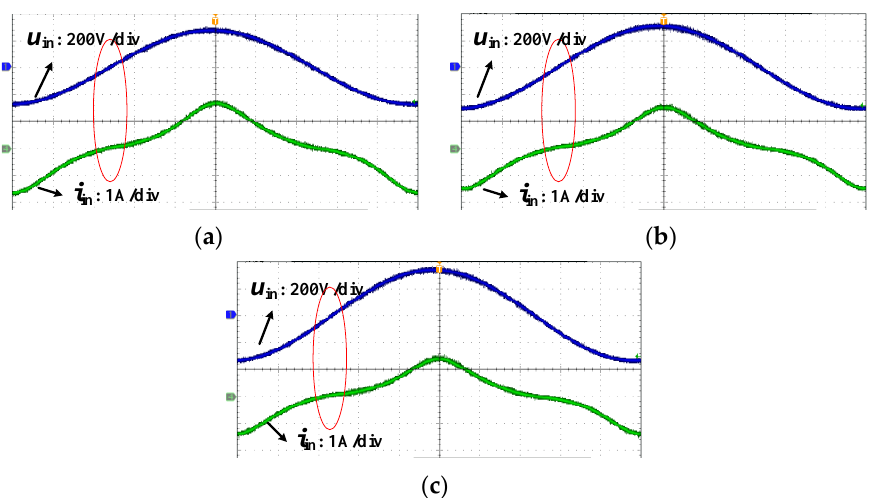
Figure 20. The enlarged waveforms of input voltage and current of Figure 19 at different input voltages. ( a ) u in = 198 V. ( b ) u in = 220 V. ( c ) u in = 242 V.